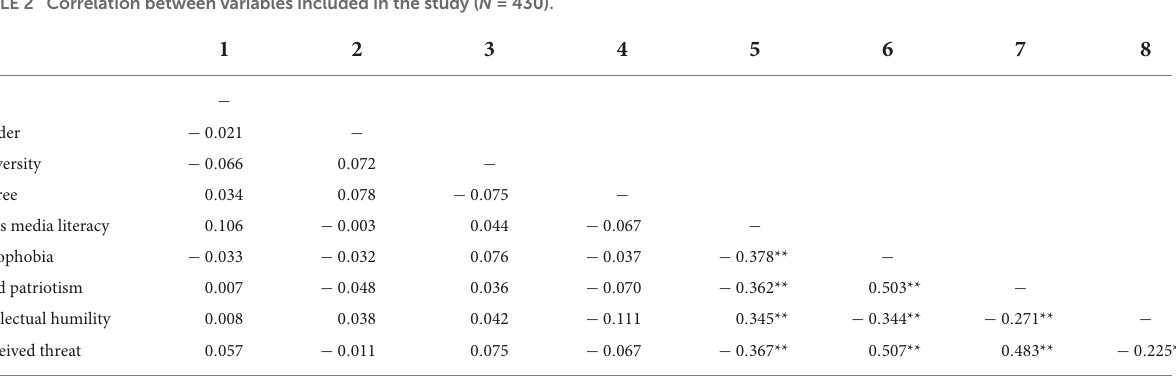
TABLE 2 Correlation between variables included in the study ( N = 430).